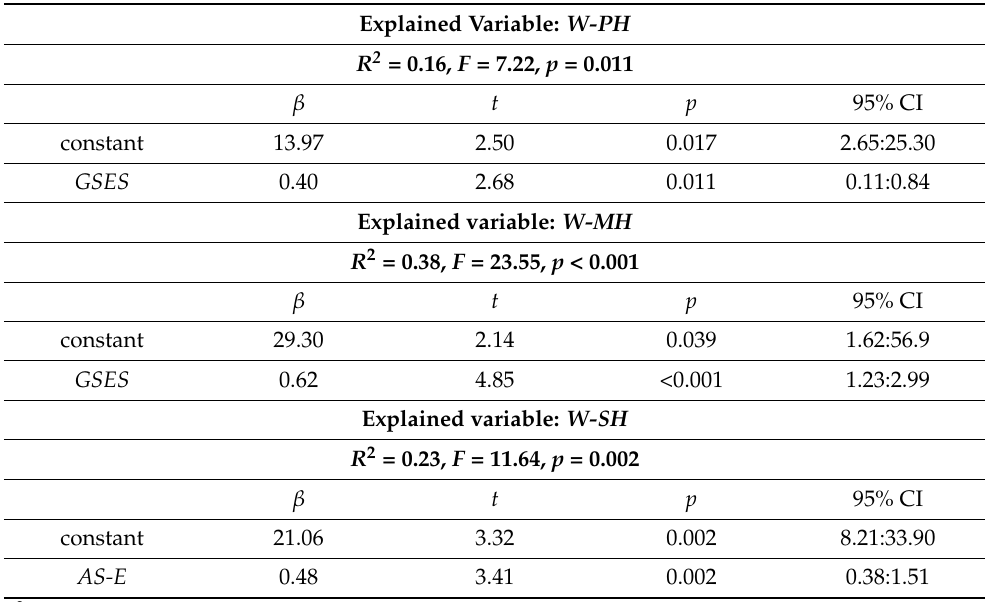
Table 3. Regressions for the perceived function of work for health dimensions—the occupationally active group.